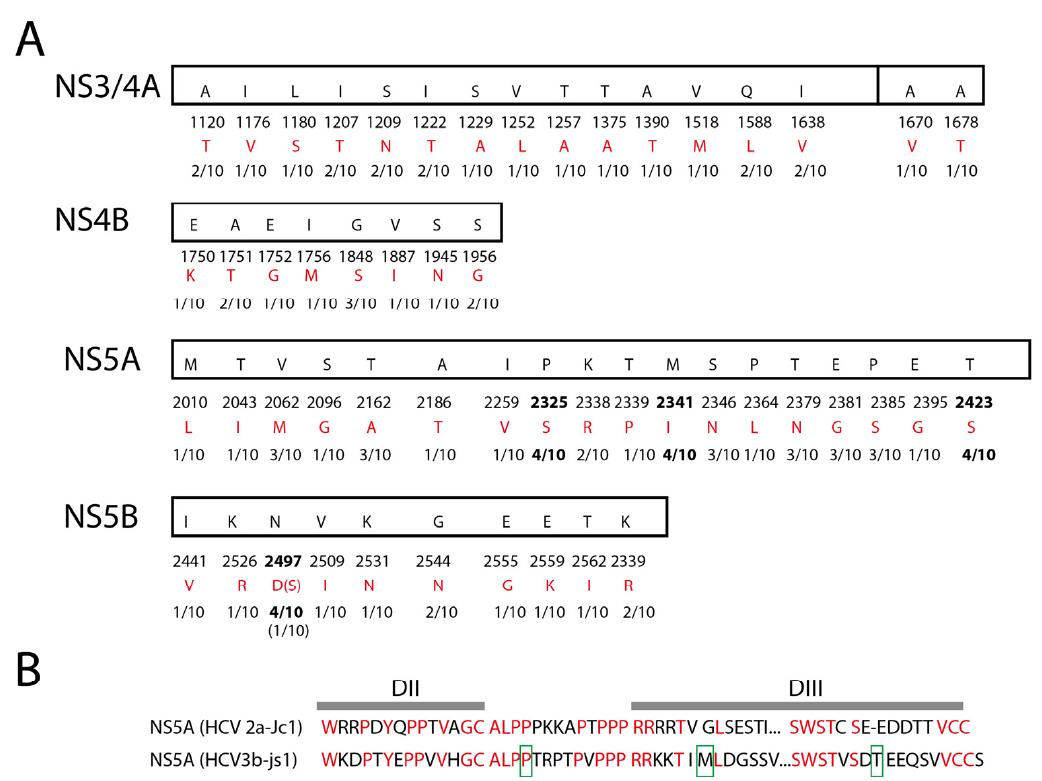
Figure 5. Amino acid variations of the viral non-structural proteins. ( A ) Summary of the amino acid variations of the viral non-structural proteins. The consensus sequences are shown in the boxes, and the positions of the amino acids are shown below the boxes. The variations of each amino acid (in red) and the ratio of the variations are shown as indicated. Variations with a ratio above 3/10 are in bold. ( B ) Alignment of HCV 3b-js1 NS5A with HCV 2a Jc1 NS5A. Domain II (DII) and Domain III (DIII) are indicated. The hotspot variations in HCV 3b-js1 NS5A are boxed in green.